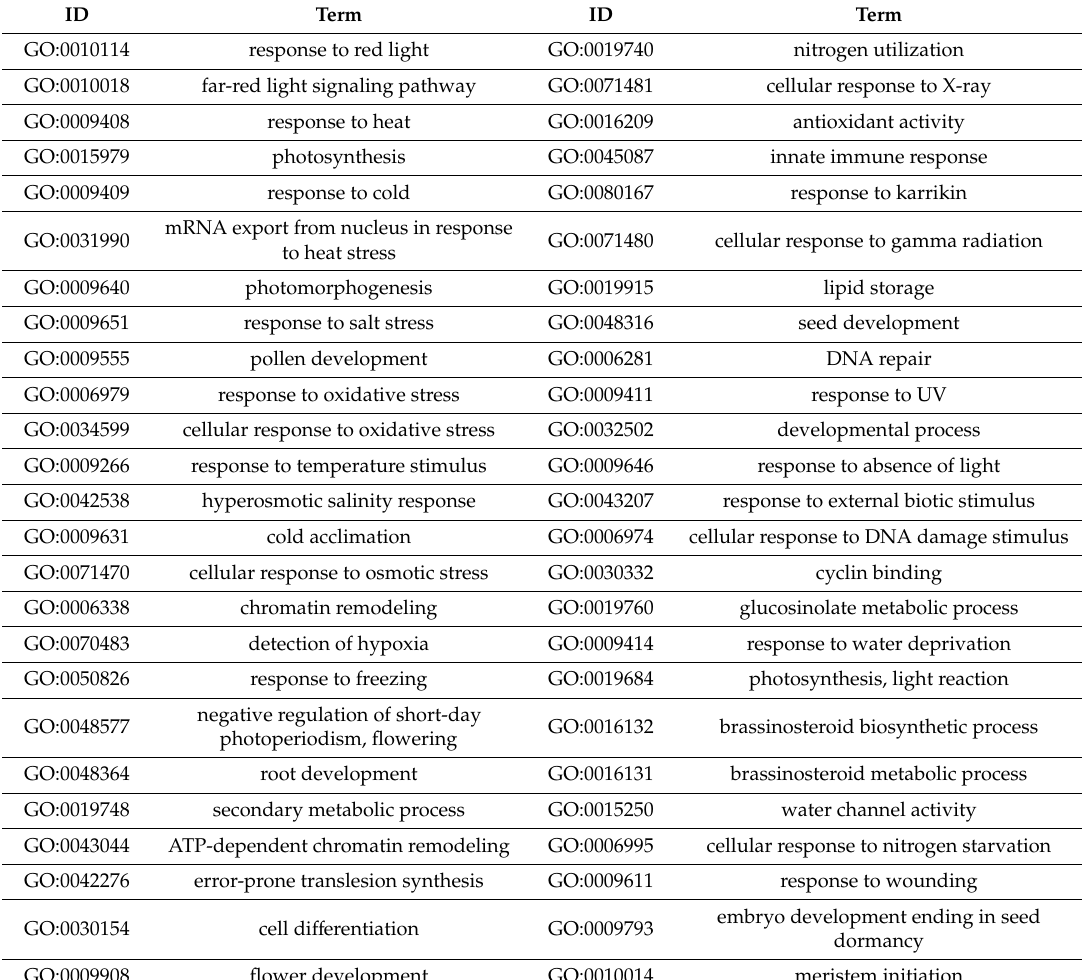
Table 1. Top 50 Gene Ontology terms ranked by semantic similarity to scientific publications on crop adaptation to climate in the United States. Rank 1–25, left; 26–50,